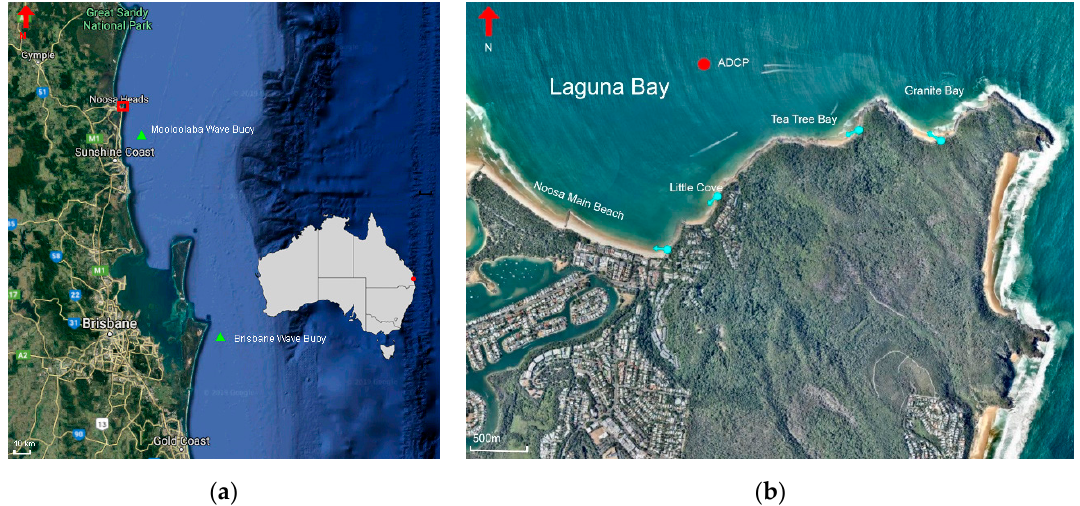
Figure 1. Noosa Headland with instrument locality for south-east Queensland ( a ) and Noosa Headland ( b ). The location and direction of monitoring photo sites is shown in ( b ) with light blue arrows. Source: Google maps ( a ) and Nearmaps.com.au ( b